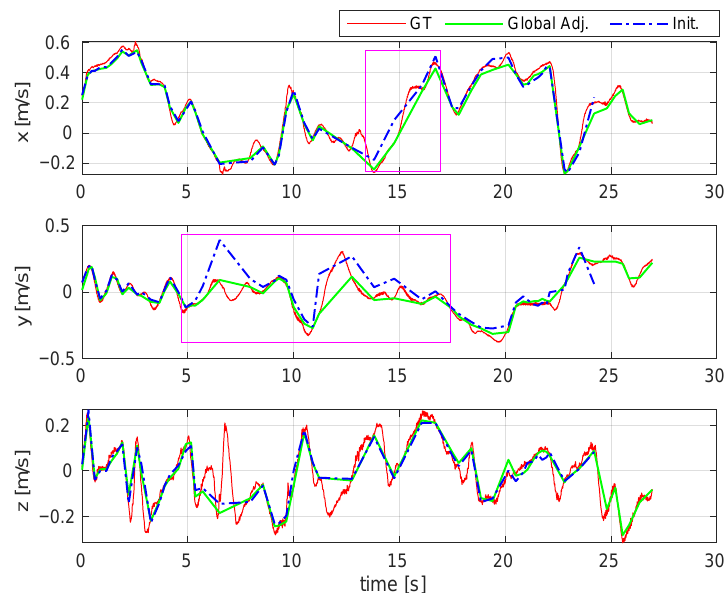
Figure 11. Comparison of the estimated IMU body velocities using the V2_01 sequence of the EuRoC dataset. Red curve: Ground-truth velocity (GT); Blue dash-dot curve: The velocity estimated by online initialization (Init.); Green curve: The velocity corrected by global adjustment (Global Adj.). Best viewed in